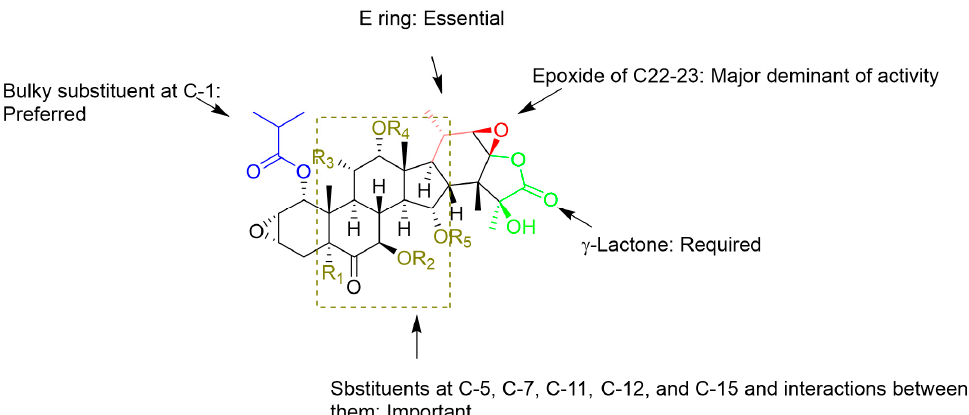
Figure 4. The structures of semi-synthetic taccalonolides (1–48).